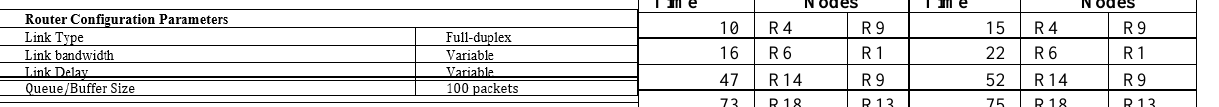
Table 1: Connectivity details of users, switch and server